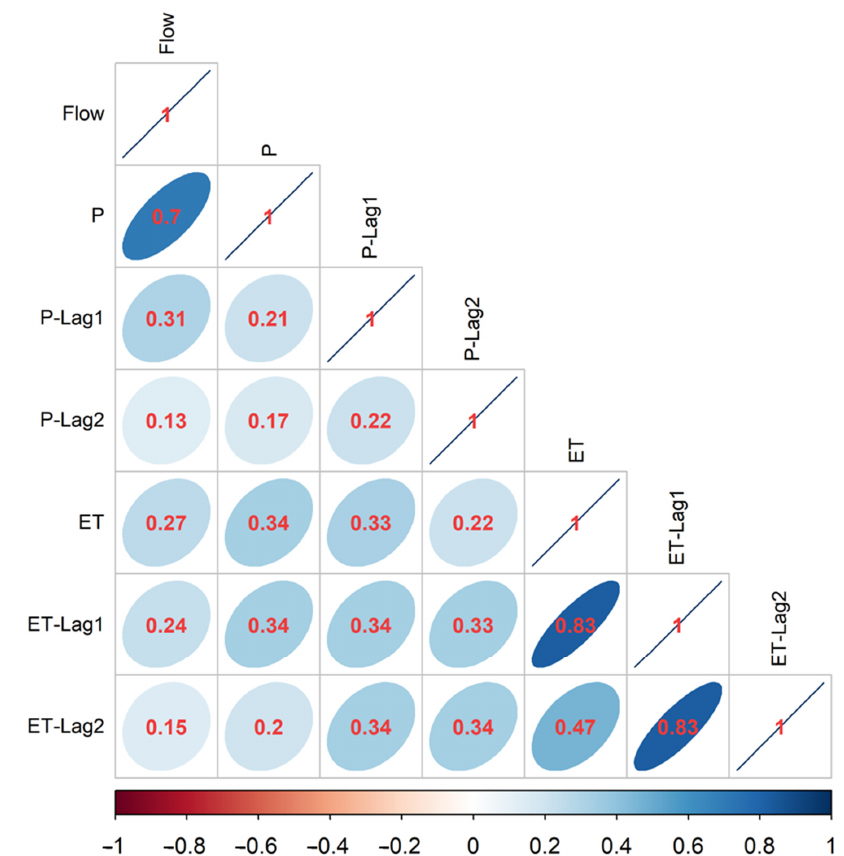
Figure 3. Correlation coefficients between the climate variables, Precipitation at each month (P), Precipitation of the last month (P-Lag1), Precipitation of the second last month (P-Lag2), Evapotran- spiration at each month (ET), Evapotranspiration of the last month (ET-Lag1), Evapotranspiration of the second last month (ET-Lag2), and the streamflow data.